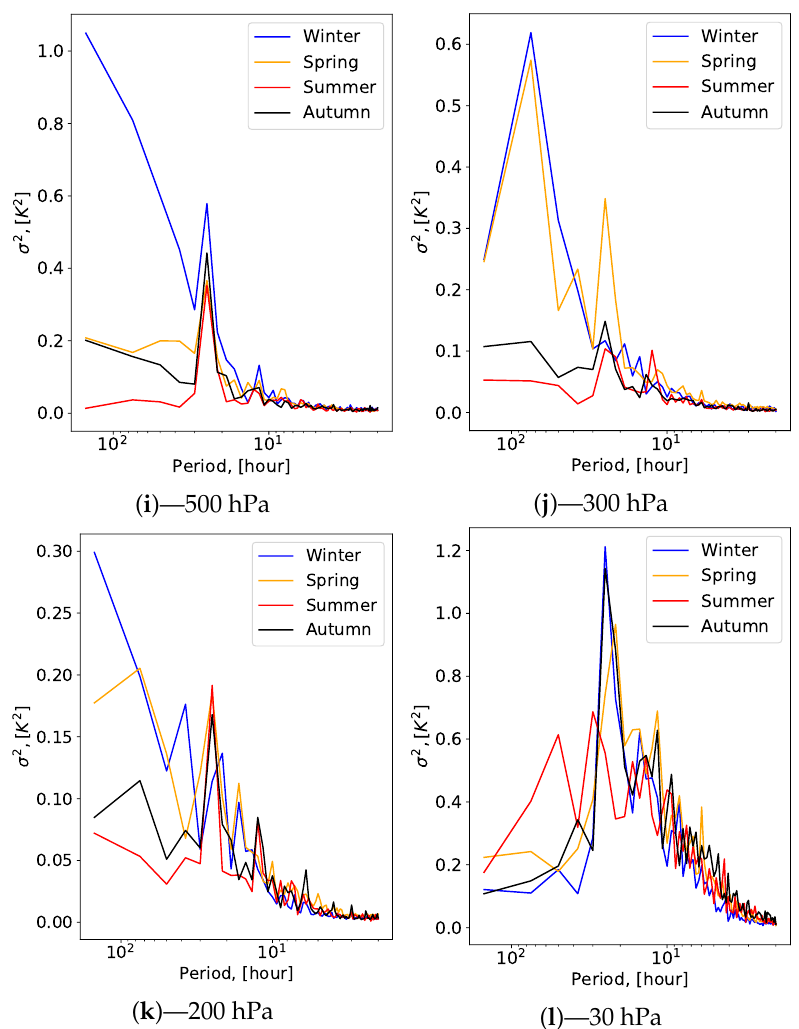
Figure 7. Energy spectra of air temperature fluctuations at the Hoa Lac observatory.